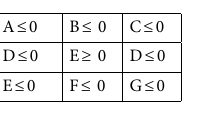
Table 2. Theoretical Kernel values.